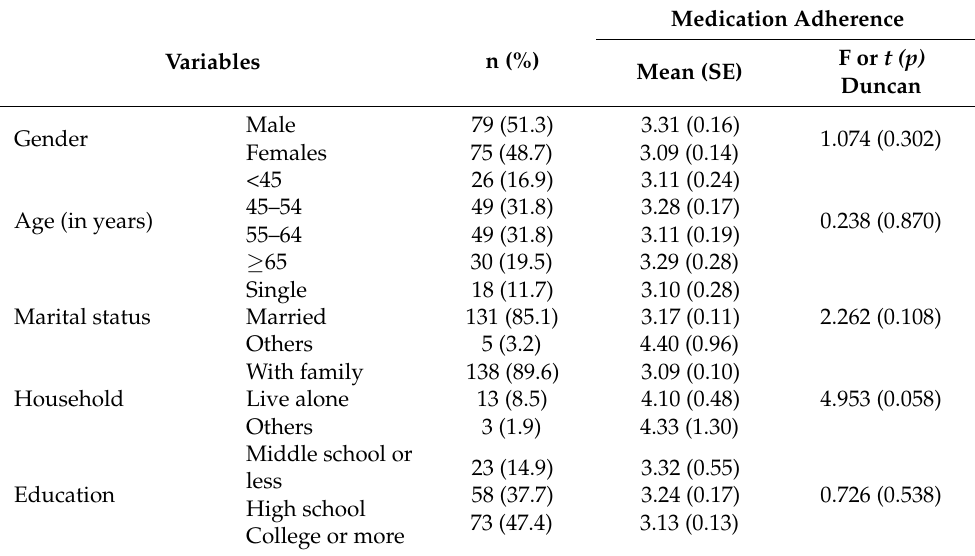
Table 3. Medication adherence according to participants’ demographic and clinical characteristics (n =